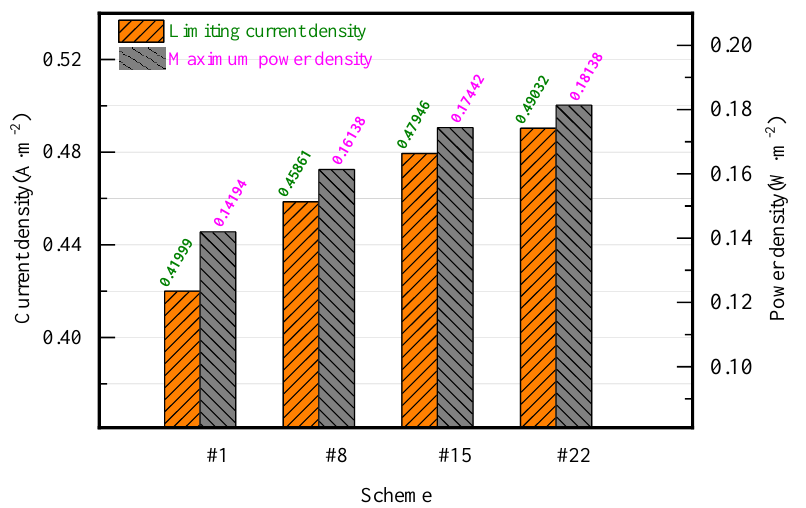
Figure 14. The limiting current density and the maximum power density between scheme #1, #8, #15 and #22.